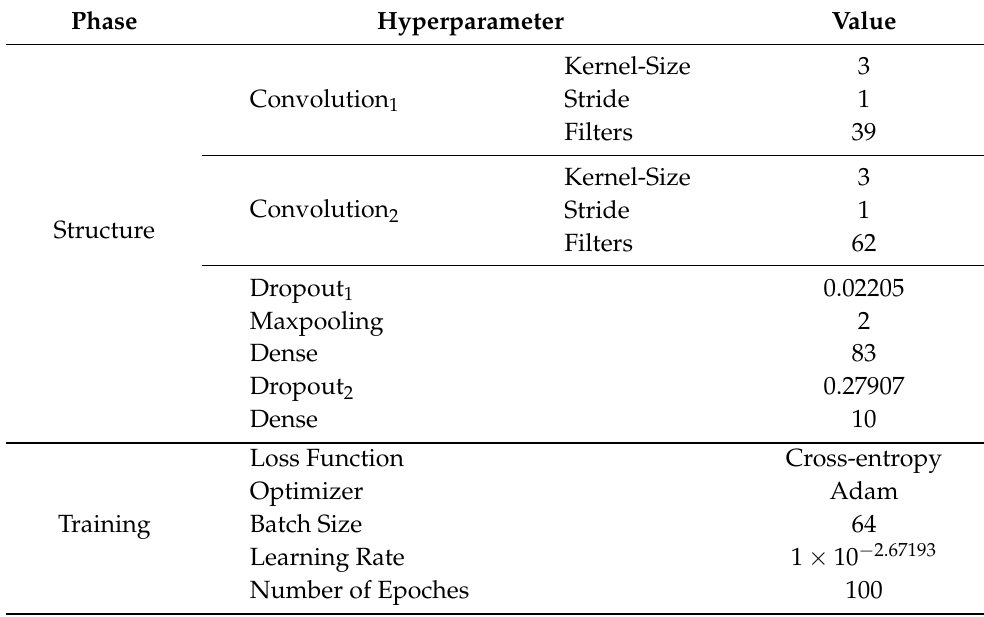
Table 6. The summarized hyperparameters of CNN-LSTM network found by